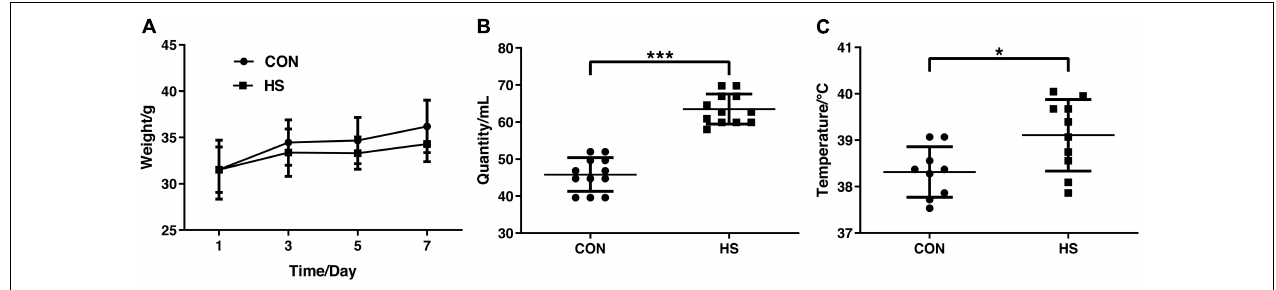
HS group ( Figure 1C ) ( n = 10 per treatment). This indicated